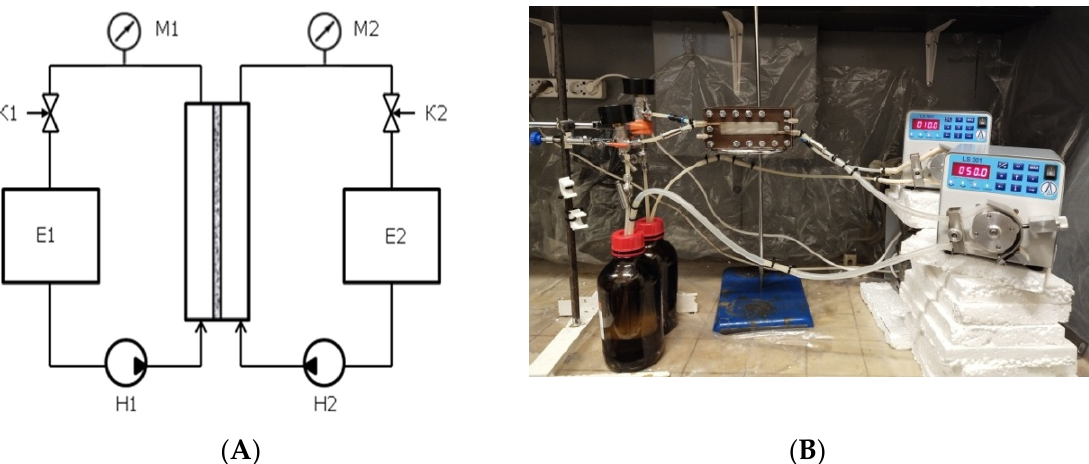
Figure 1. ( A ) Structural scheme and ( B ) external view of the setup for determining the stability of the interface in the liquid–liquid membrane contactor. M1, M2—manometers; K1, K2—fine adjustment valves; E1, E2—technological reservoirs containing water and organic liquid, respectively; H1, H2—peristaltic pumps.